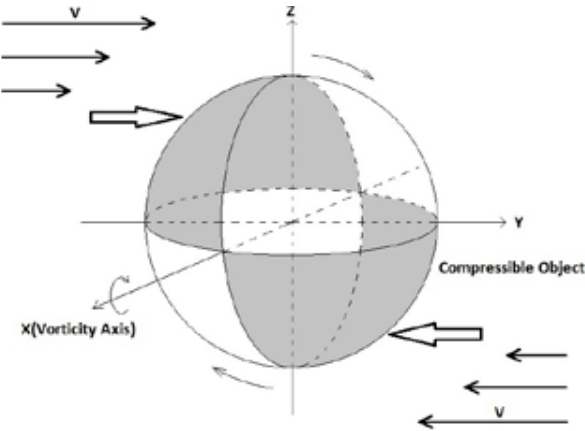
Figure 2. Schematic showing the polymer represented as a sphere in Couette flow. At semi-dilute concentrations each sphere is in “contact with the surrounding spheres. The shaded area shows the region which experiences a compressive force from the flow. The upper half experiences a compressive force from left to right while the bottom right hand part of the image experiences a similar com- pressive force from the flow from right to left. Each surface experi- ences a compressive force equal to one half the Stokes’ drag on a sphere. The total compressive force is then equal to f compressive = f hyd = 6 πηrU where η is the solution viscosity, r the sphere radius and U the velocity difference across the sphere in the direction shown. The sphere also experiences a torque around the vorticity axis. This rotational motion causes a tumbling which yields an averaged sym- metric compression on the blobs in flow. At each point across the surface the hydrodynamic force is equal to the elastic force under steady shear. Local fluctuations will occur with the system reaching an average reduced size of the coil with increasing shear rate and commensurate hydrodynamic force. The arrows pointing inward on the blob represent the local hydrodynamic compressive